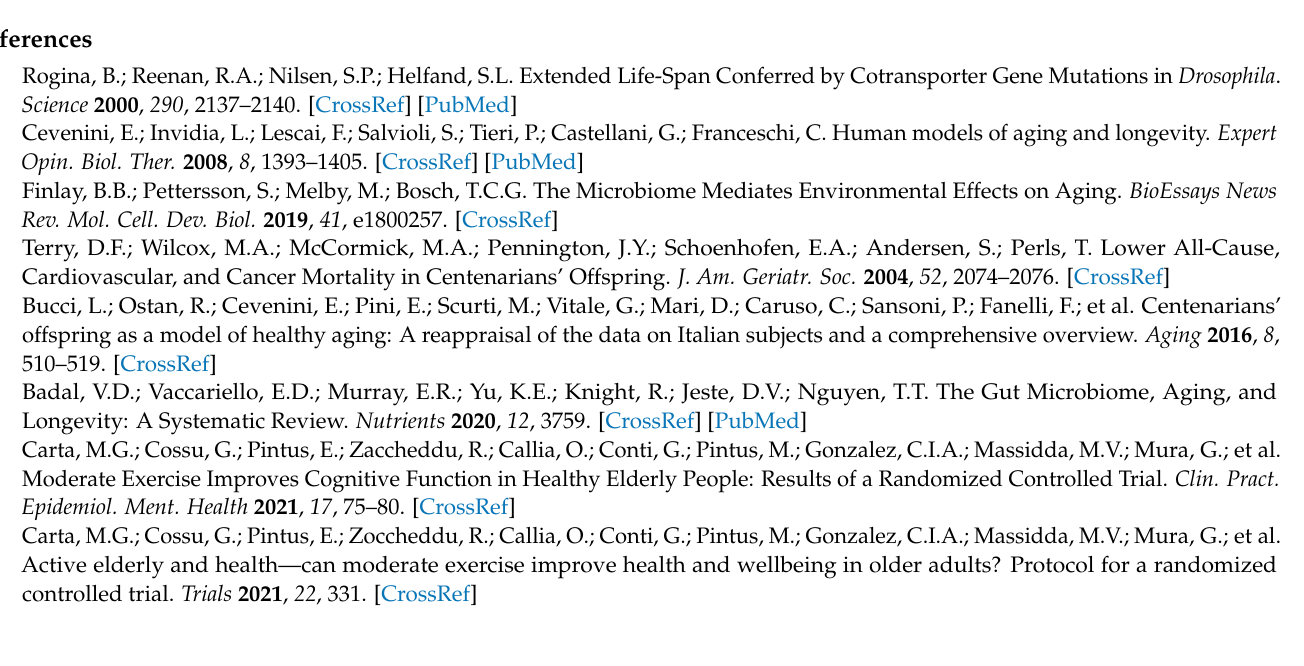
Table S3: GM beta diversity analysis between CPAR and COFF; Table S4: 29 Statistically significant common differences in the relative abundance of bacterial taxa in the two classes of LLS compared to CTLs; Table S5: 24 Statistically significant divergences in the relative abundance of bacterial taxa observed only from the comparison between CENT and CTLs; Table S6: 41 Statistically significant divergences in the relative abundance of bacterial taxa observed only from the comparison between NON and CTLs; Table S7: 8 Statistically significant divergences in the relative abundance of bacterial taxa observed from the comparison between CENT and NON; Table S8: Spearman’s correlation between significant taxa and dietary, lifestyle and clinical parameters in CENT; Table S9: Spearman’s correlation between significant taxa and dietary, lifestyle and clinical parameters in NON. The anthropometric and lifestyle factor assessments can also be found in Supplementary Materials, in the sections “Anthropometric evaluation” and “Lifestyle factor